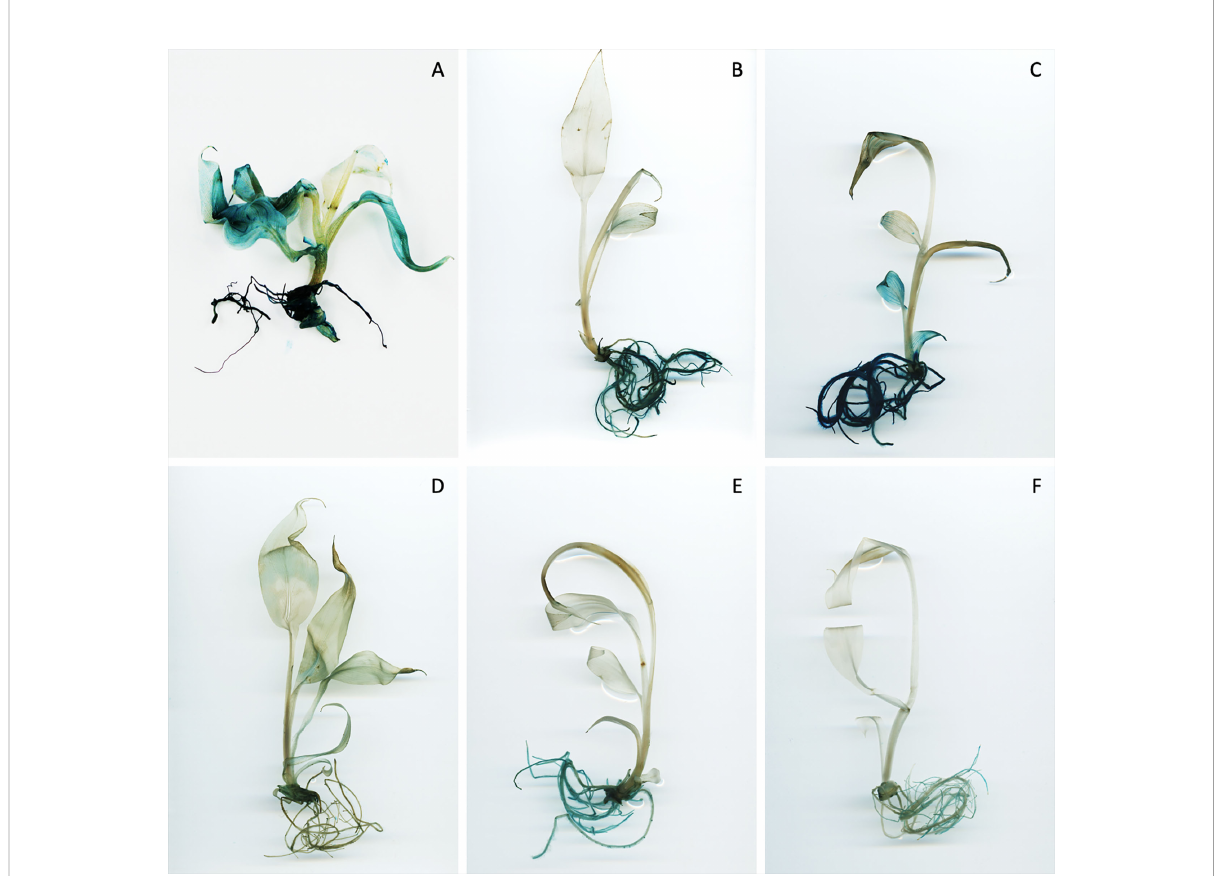
FIGURE 3 Expression pattern of promoter- uidA constructs in root and leaf tissues of selected transgenic banana lines. Transgenic promoter- uidA banana plants were generated and whole plants were stained to visualise GUS activity. Representative images selected from eight replicates per construct. Promoter constructs shown include (A) ZmUbi, (B) FaRb7, (C) ZmGLU1, (D) OsRCg2, (E) MaTIP2-2a and (F)